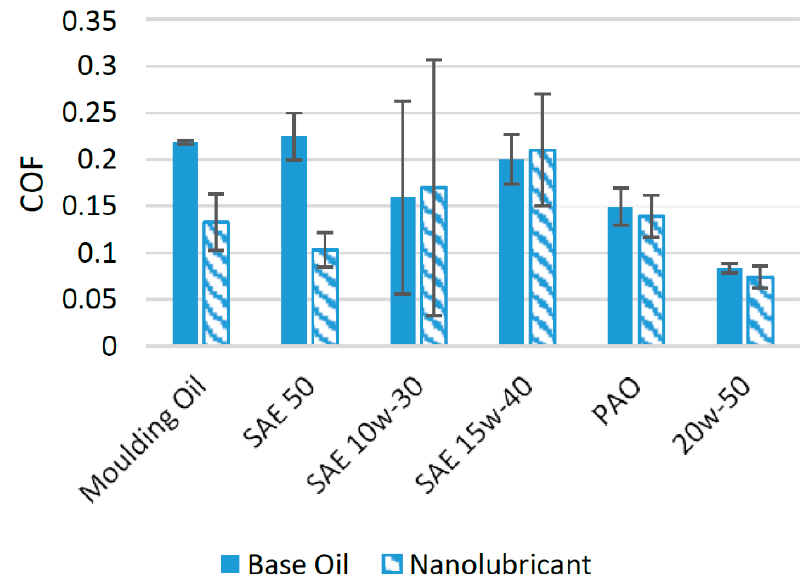
Figure 10. Effect of CuO NPs on the friction performance of synthetic lubricants.